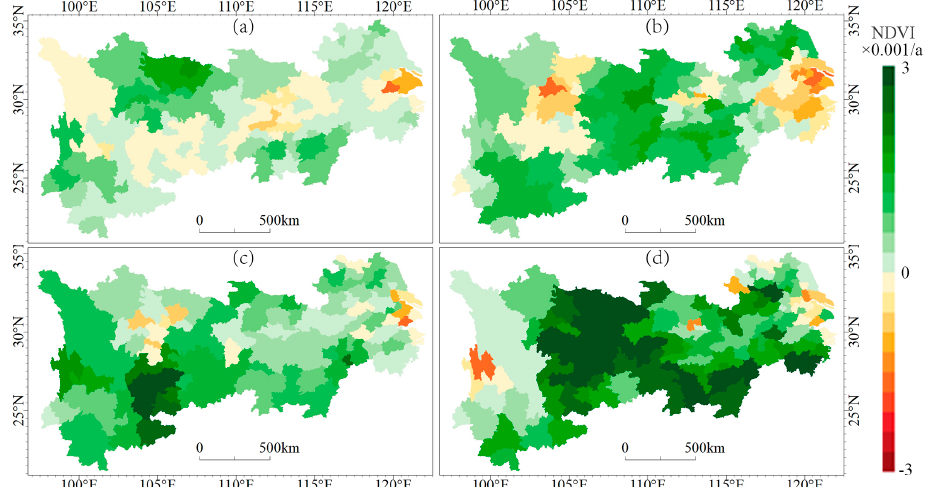
Figure 7. Predicted NDVI (i.e., NDIV pre ) changes using precipitation and temperature (left panel ( a , c )) and its residual (i.e., NDIV res ) changes (right panel ( b , d )) for periods from 1982 to 2003 (top panel ( a , b )) and from 2003 to 2019 (bottom panel ( c , d )).